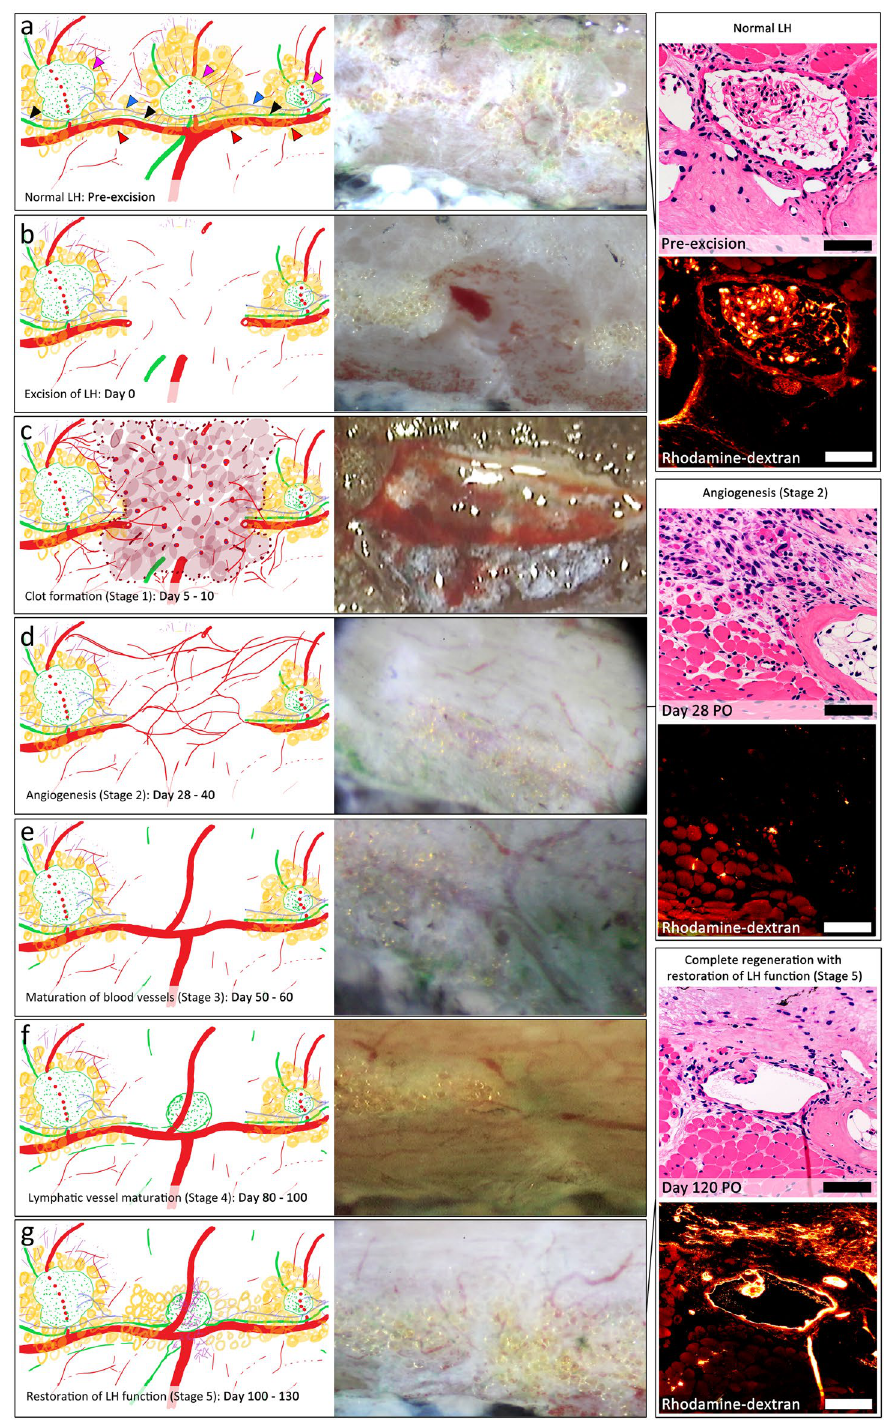
Figure 6. Morphological stages of lymphatic heart regeneration following complete excision. ( a ) Normal lymphatic heart (LH) (magenta arrowheads) with its supplying nerve (blue arrowheads), the trunci lymphatici longitudinales lateralis (TLyLL) (black arrowheads) and venous lateralis (VL) (red arrowheads). LH function was confirmed by collection of rhodamine-dextran (Scale bars = 100 μm). ( b ) The tissue defect immediately after LH excision. A segment of the TLyLL, VL and the supplying nerve, all of which are intimately associated with the LH were also resected. ( c ) Stage 1 Post Operative (PO) Day 5–10: Clot formation was followed by accumulation of a soft, fragile tissue mass beneath the wound epidermis. ( d ) Stage 2 PO Day 28–40: Angiogenesis of several small blood vessels interconnecting the cut ends of the VL and the other major blood vessels. No lymphangiogenesis seen at the injury site. Histology showed regenerating muscle and fibroblasts but no functional lymphatics with no rhodamine-dextran collection. ( e ) Stage 3 PO Day 50–60: Maturation of blood vessels restoring their original size and structure and restoration of VL continuity. Small lymphatic vessels were observed sprouting from the edges of the wound towards the injury zone. ( f ) Stage 4 PO Day 80–100: Lymphatic vessel maturation with active flow and collection of dye observed as a cystic mass in the region of the original LH, but no pulsations. ( g ) Stage 5 PO Day 100–130: Complete LH regeneration with pulsation. The regenerated LHs had fully functional input and output valves and uptake of rhodamine-dextran confirming they were fully